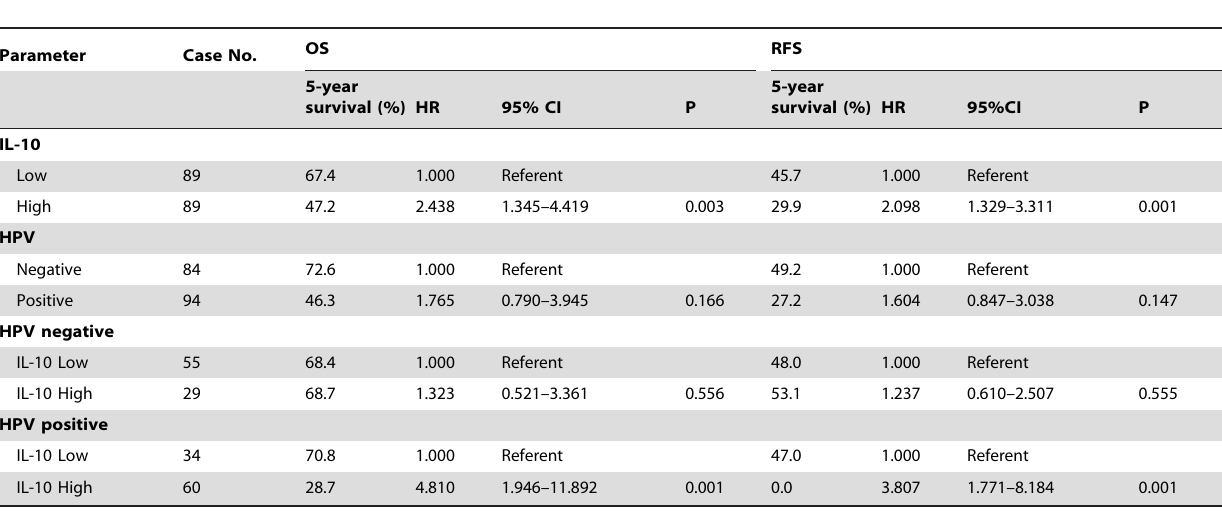
Table 3. Multivariate analysis of the influence of HPV 16/18 expression and IL-10 mRNA expression on overall survival (OS) and relapse free survival (RFS) in oral cancer